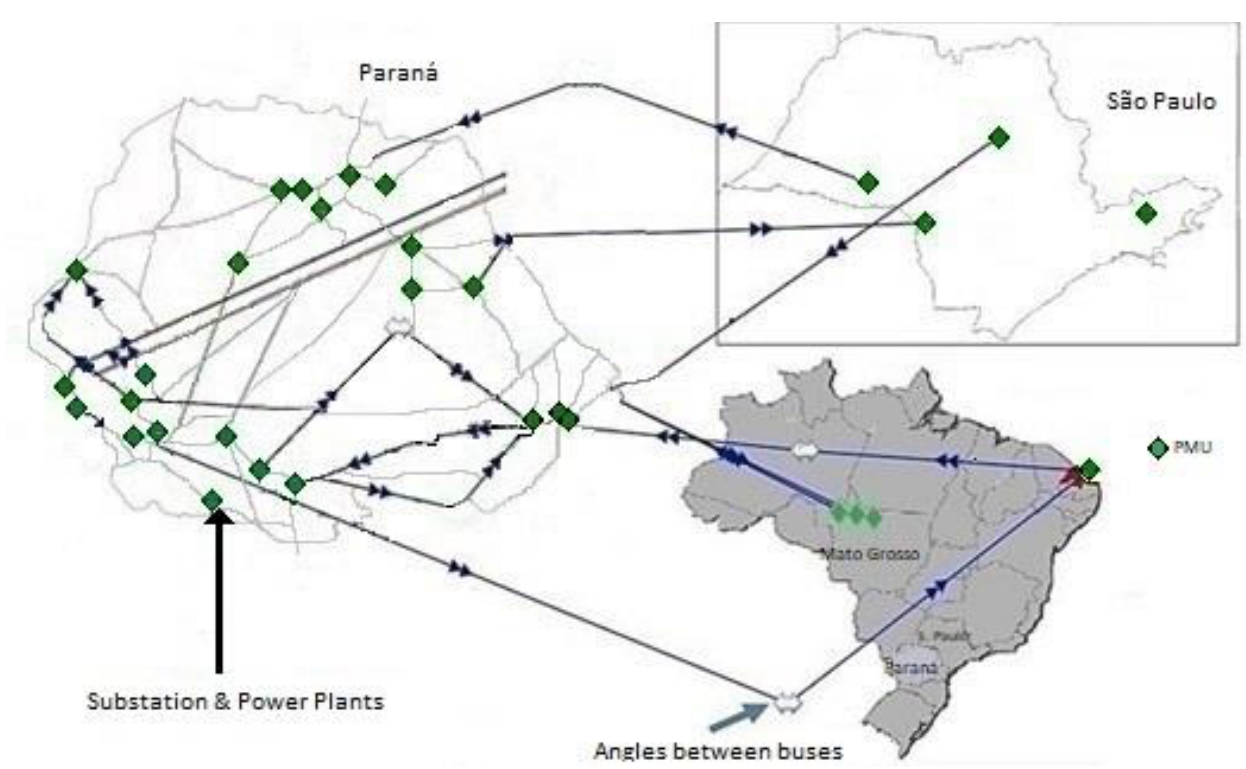
Figure 1. Localization of PMUs (green diamonds) — Copel GeT (adapted from [18]).